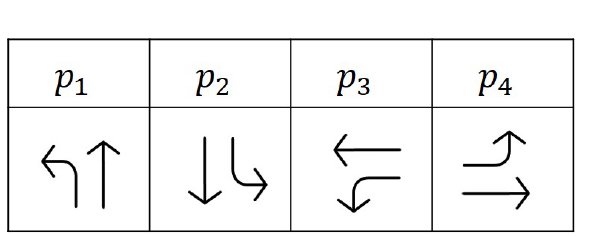
Figure 6. The possible movement signal phase in a 4-way intersection.